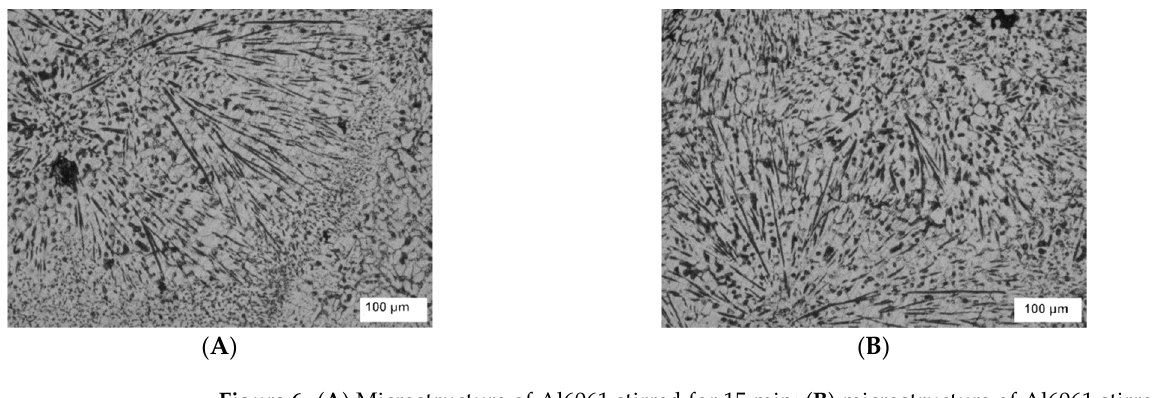
Figure 6. ( A ) Microstructure of Al6061 stirred for 15 min; ( B ) microstructure of Al6061 stirred for 20 min.